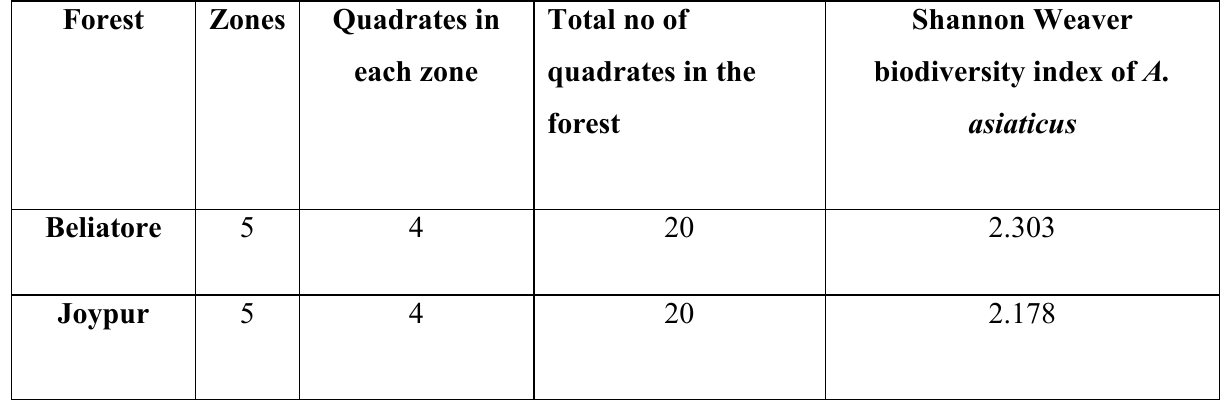
Table 4 Shannon Weaver biodiversity index of the association between Astraeus asiaticus and Shorea